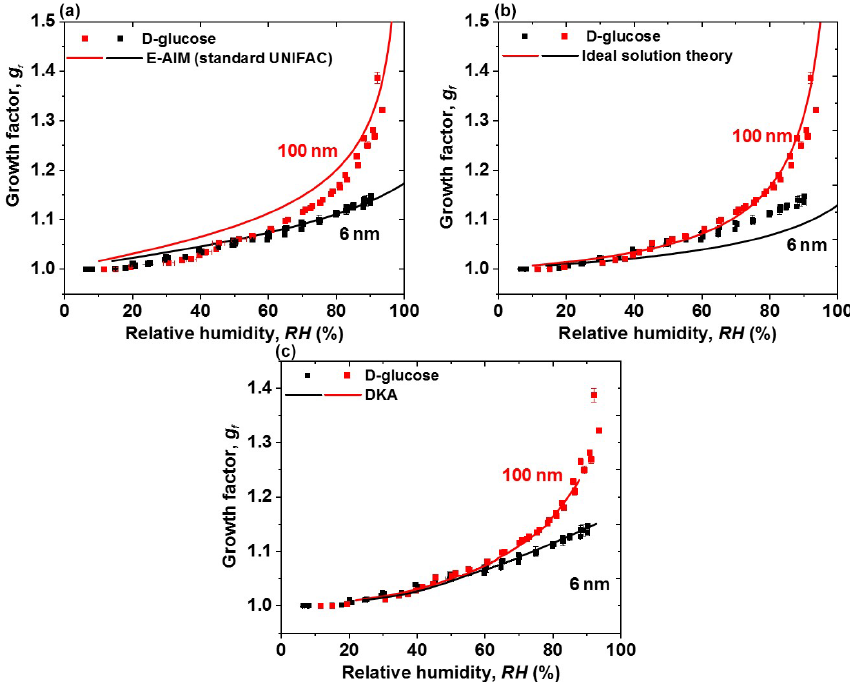
Figure 9. Hygroscopic diameter growth factor ( G f ) of D-glucose nanoparticles with dry diameters of 100nm (red square) and 6nm (black square). Köhler model curves are based on (a) AIM (standard UNIFAC), (100nm: red, 6nm: black line), (b) ideal solution theory (100nm: red, 6 nm: black line), and (c) DKA mode (100nm: red, 6nm: black